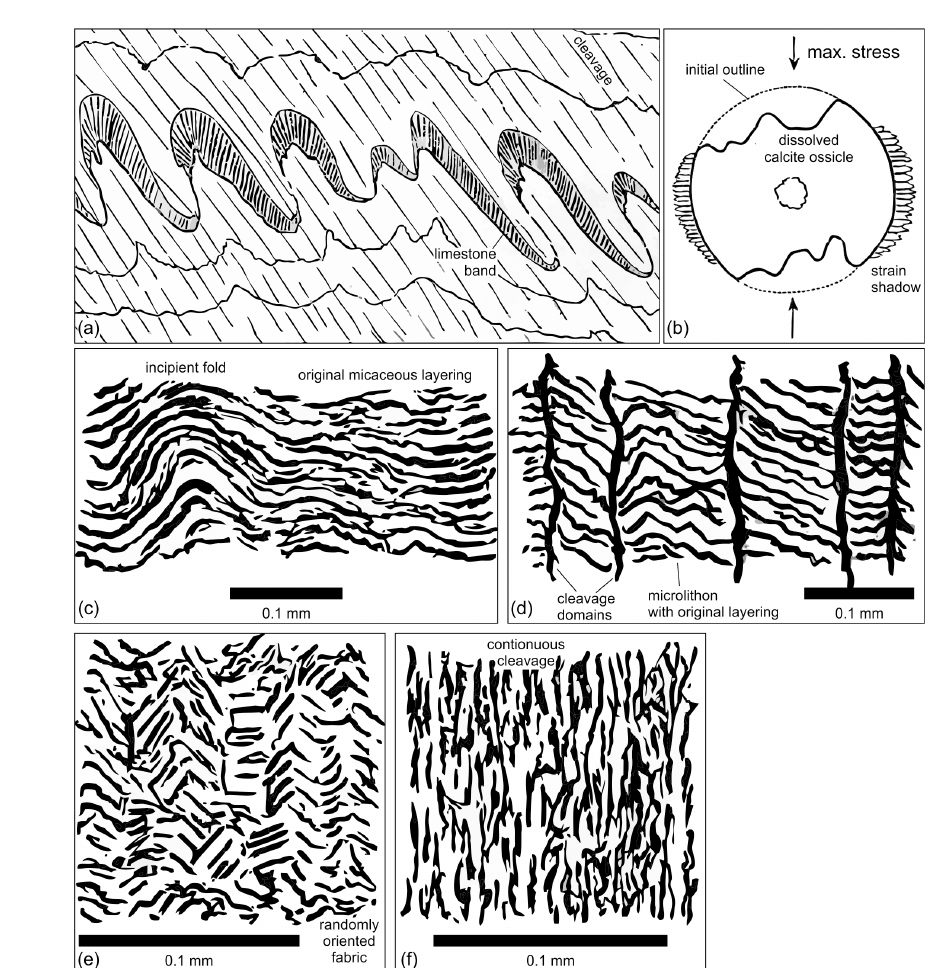
Figure 3. (a–b) Figures redrawn from Sorby (1879), no scale in the original (see original description in text). (a) Folded limestone band from Ilfracombe, in which Sorby described rootless folds and transposition cleavage, formed by pressure–solution along folds’ limbs. (b) A crinoid ossicle seen under the microscope, with dissolved edges and calcite fibers in the strain shadows and with the interpreted direction of maximum stress. (c–d) Figures redrawn from Sorby (1880), showing the progressive deformation of a slate. Textual captions between brackets (see text for original description). (c) “Slate, Liskeard, with minute contortions”; the fine micaceous sedimentary lamination is deformed into open or gentle microfolds. (d) “Slate, Liskeard, with planes of discontinuity”; further contraction causes the formation of an imperfect cleavage, in which Sorby recognized the concentration of oxides. (e) “Slate, Shap, disturbed by pressure”; in this case the first stage does not develop gentle folds, instead disturbing the original layers into a randomly oriented fabric with possibly minor kinks. This may also be the case of a rock without a clear primary fabric. (f) “Slate, Llanberis, with well–developed cleavage”; this final stage shows a continuous cleavage developed under higher